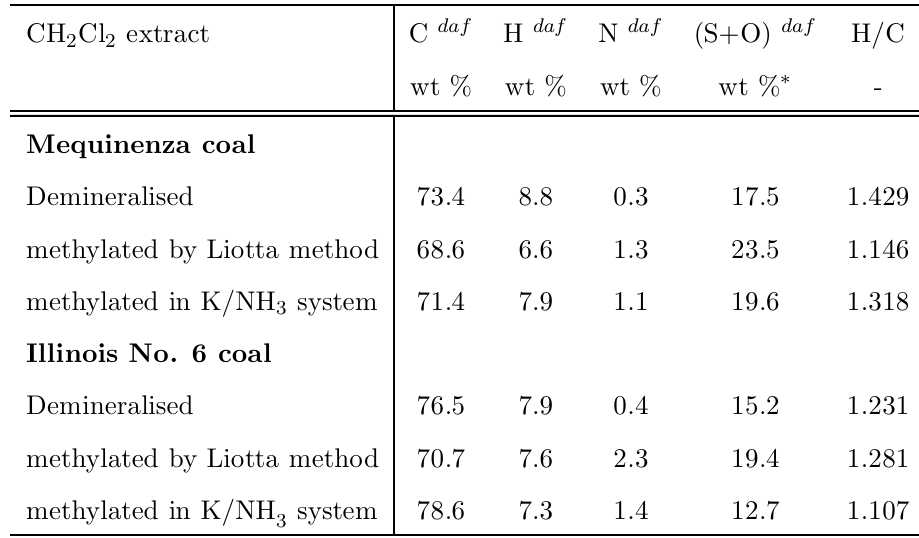
Table 2 Elemental analyses of CH 2 Cl 2